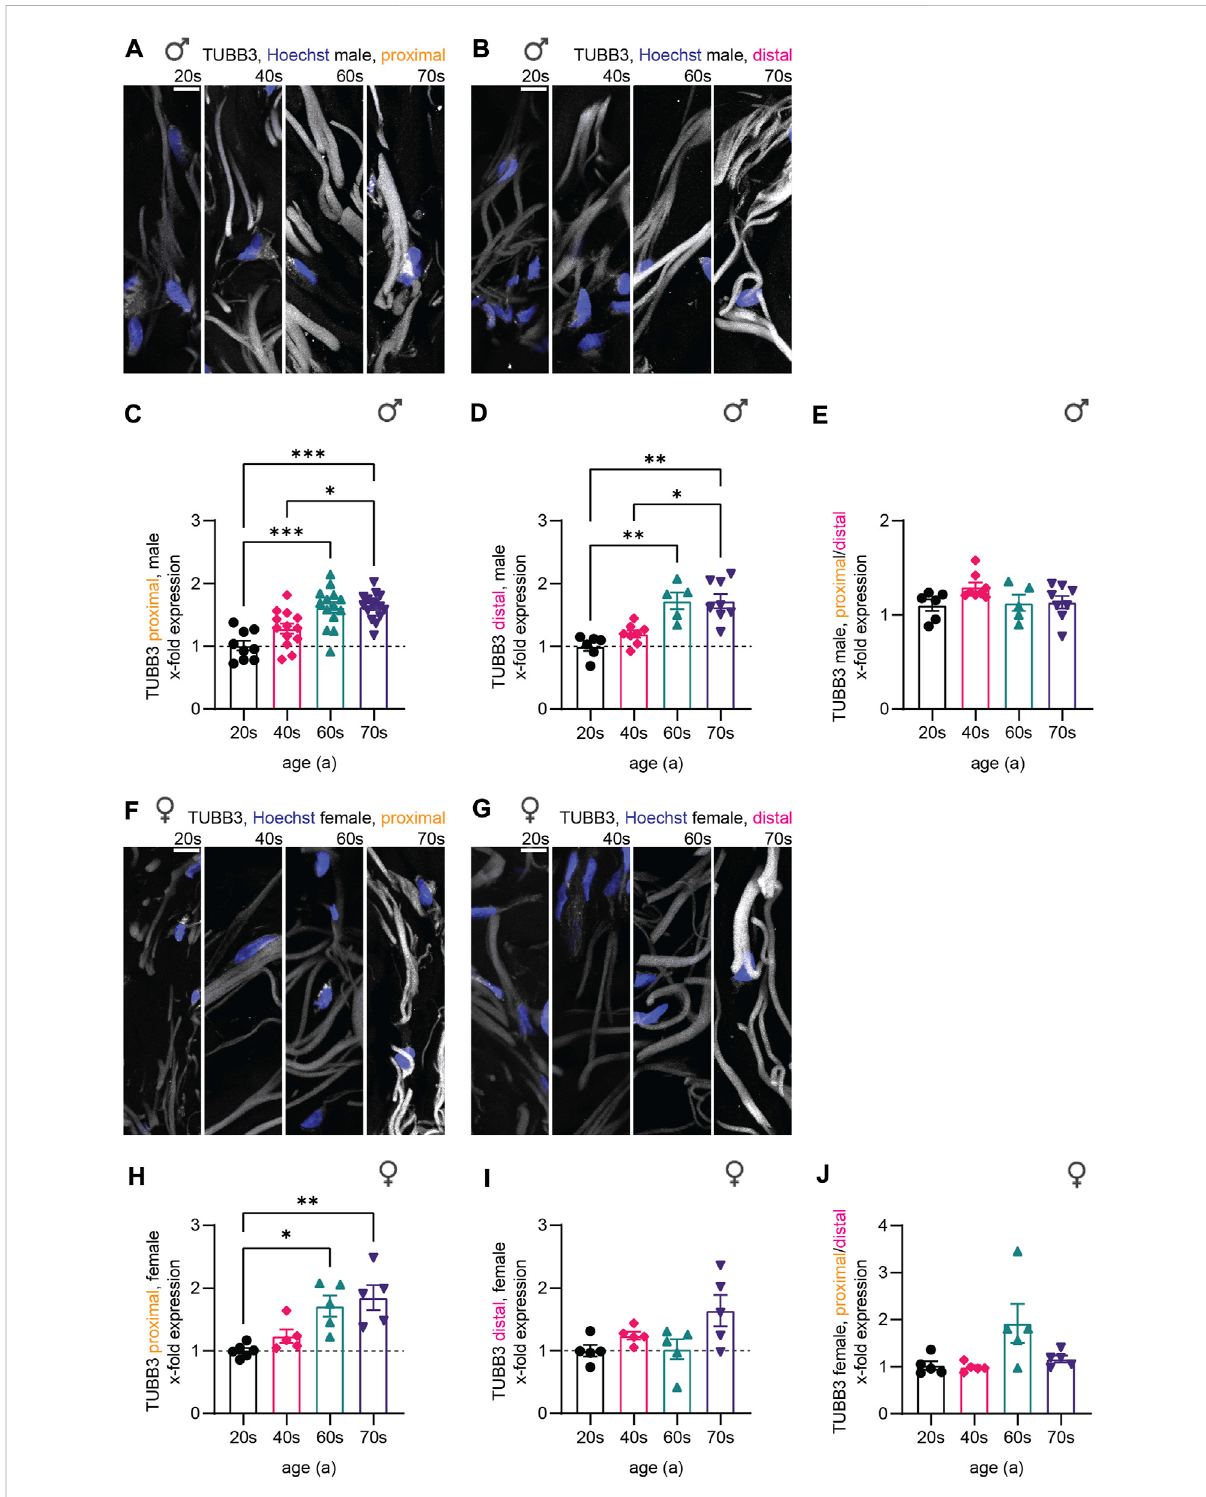
FIGURE 4 Quantitative immunostaining of human skin sections for TUBB3. (A,B,F,G) Confocal images of human skin biopsies immunostained for TUBB3 (white)withnuclearstain(Hoechst,blue)takenfromindividualsofthefouragegroups(20s,40s,60s,and70s)from (A) maleproximal, (B) maledistal, (F) female proximal, and (G) female distal samples. (C,D,H,I) Quanti fi cation of TUBB3 gray values in sensory axons (x-fold normalized to average of 20sgroup) (3 images per individual, ≤ 20axons per image, (C) n =51 individualsinproximalmale, (D) n = 27in distal male, (H) n = 21 inproximal female, (I) n = 20 in distal female data). (E,J) Male and female proximal and distal sample sets were compared via the proximal/distal TUBB3 expression ratio. Scale bars in (A,B,F,G) are 10 µm. Points in graphs (C,D,H,I) represent on individuals. Data represent mean ± SEM. Kruskal – Wallis test with Dunn ’ s multiple comparisons test. * p < 0.05, ** p < 0.01, *** p <